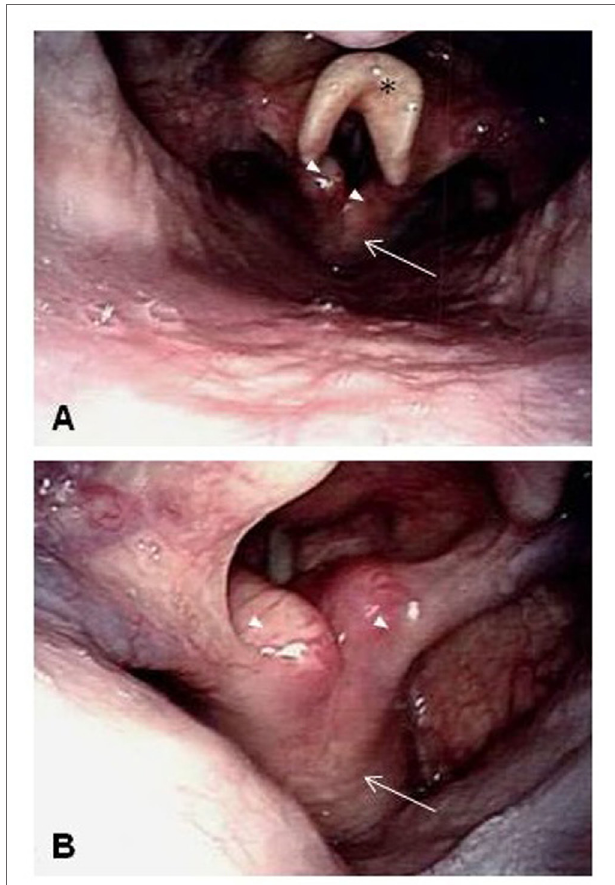
FIGURe 2 | Laryngoscopy confirmed the diffuse enlargement of the cricoid cartilage with circumferential subglottic narrowing. (a) The epiglottis (black asterisk), arytenoid cartilages (white arrow heads), and enlarged cricoid cartilage (white arrow). (B) A magnified view of the enlarged cricoid cartilage (white arrow) and arytenoid cartilages (white arrow heads). FIGURe 3 | CT-guided biopsy of the mass in the cricoid